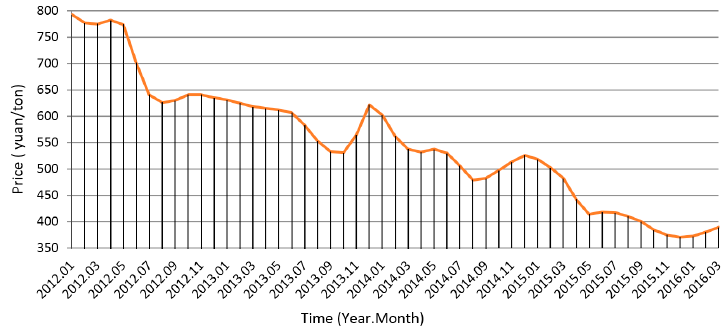
Figure 1. Monthly price of steam coal in Bohai Rim.